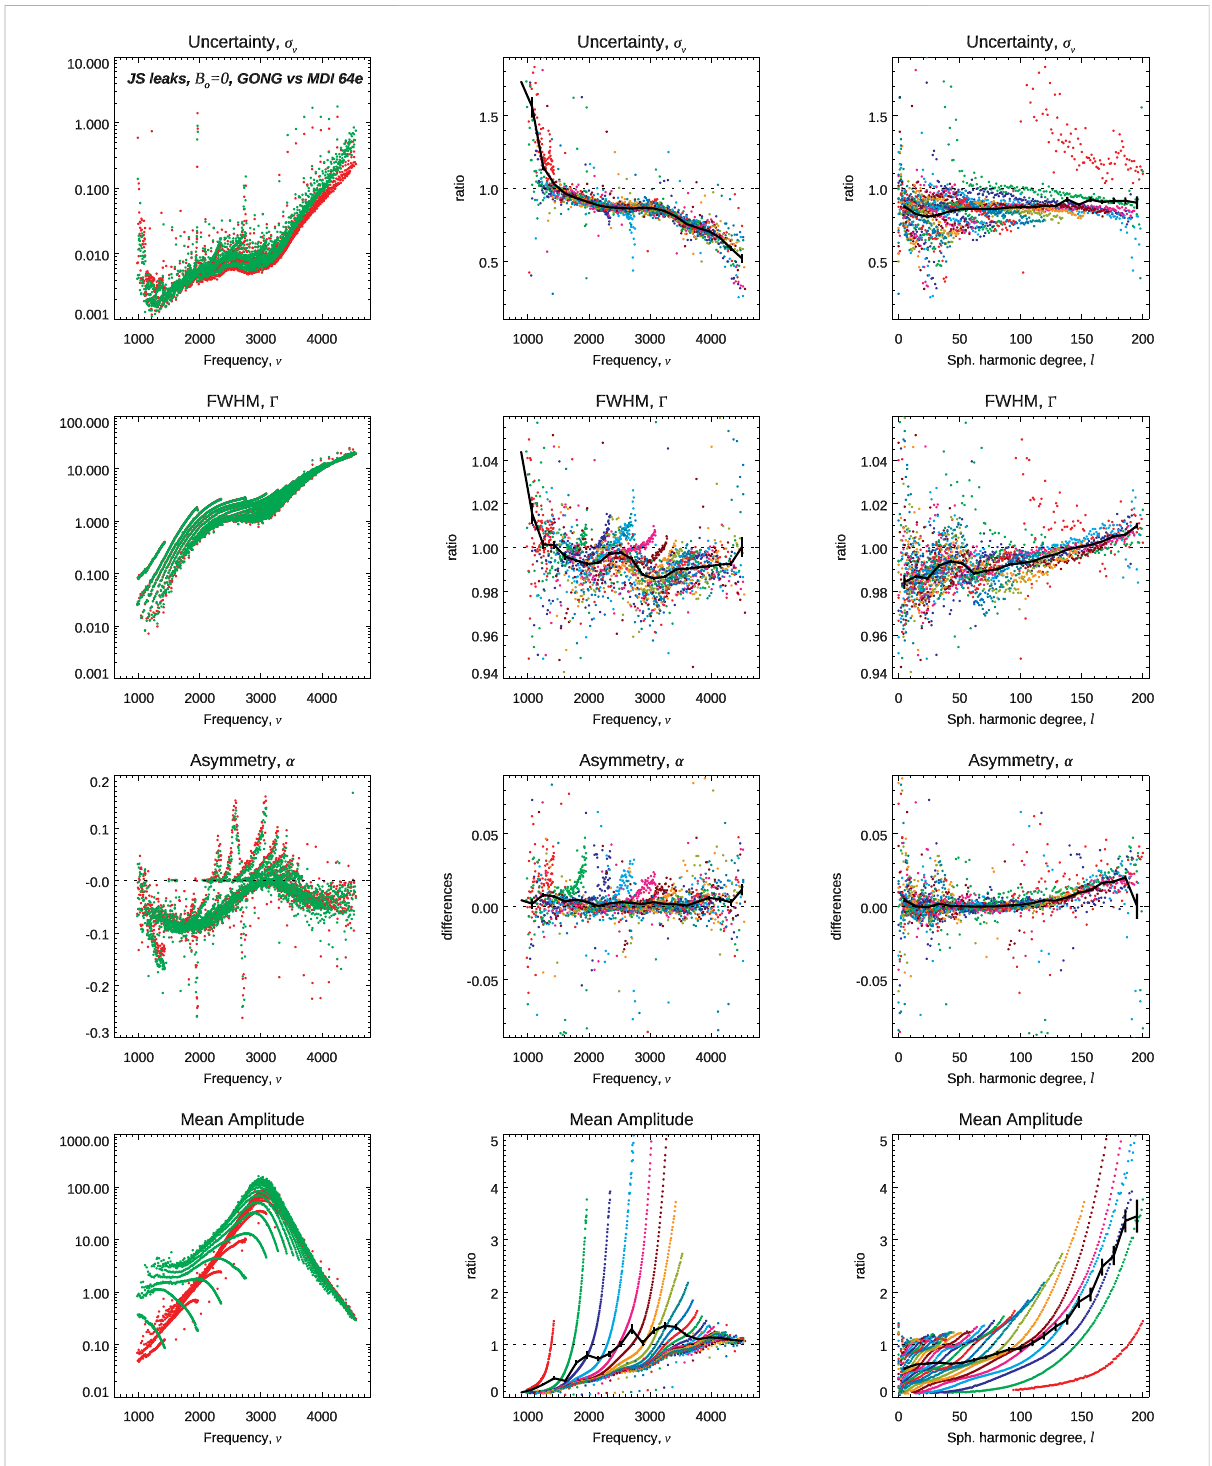
FIGURE 10 Comparison of mode characteristics, σ ] , Γ , α , and (cid:2) A ratios or differences, when fi tting a coeval 4,608-day-long time series of GONG or MDI